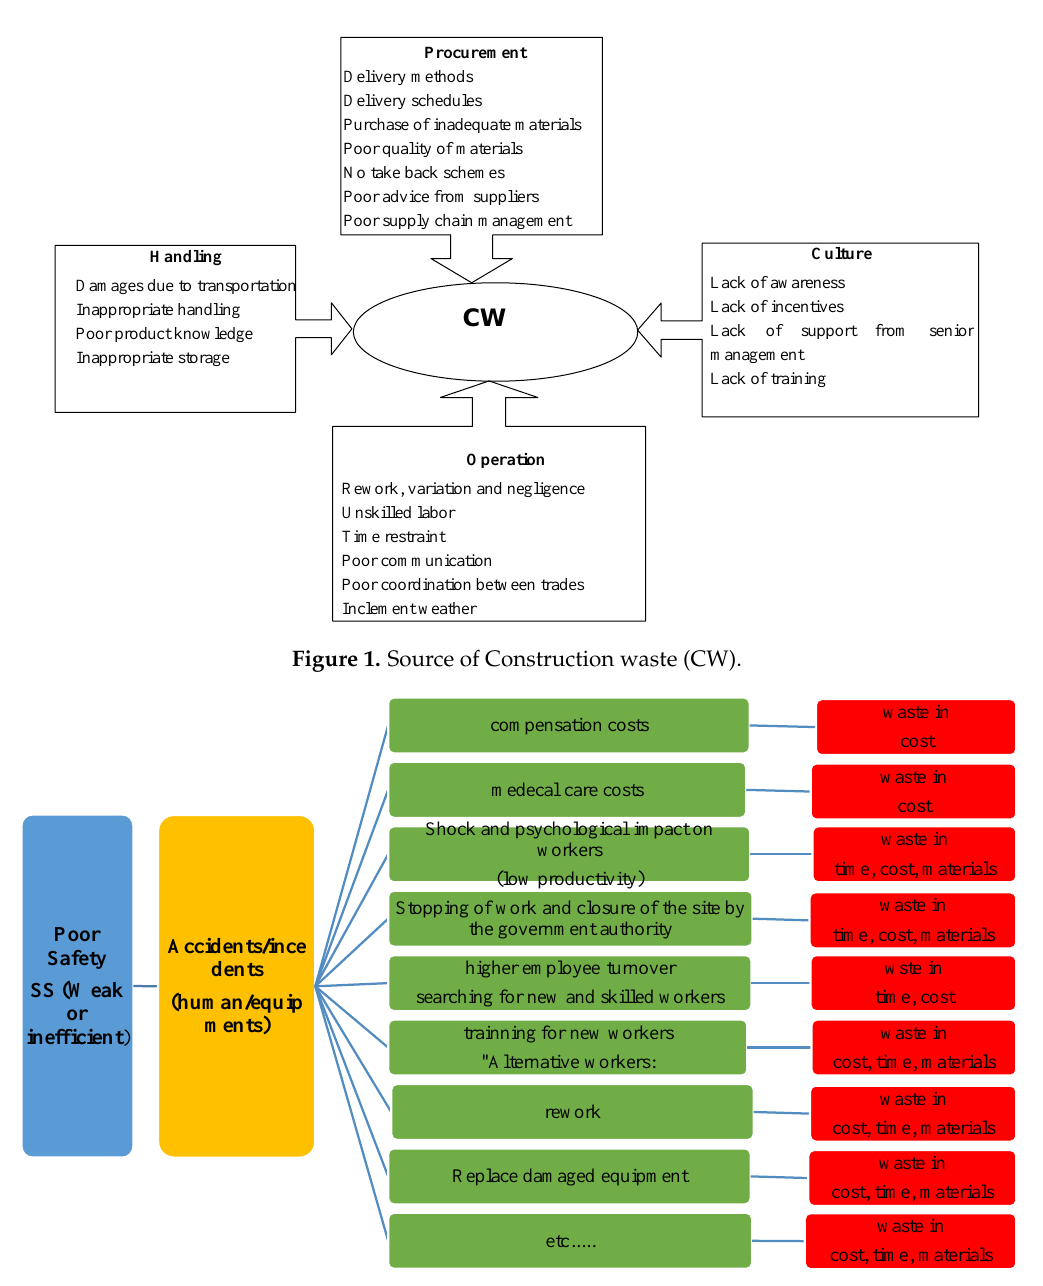
Figure 2. Impact of poor safety.